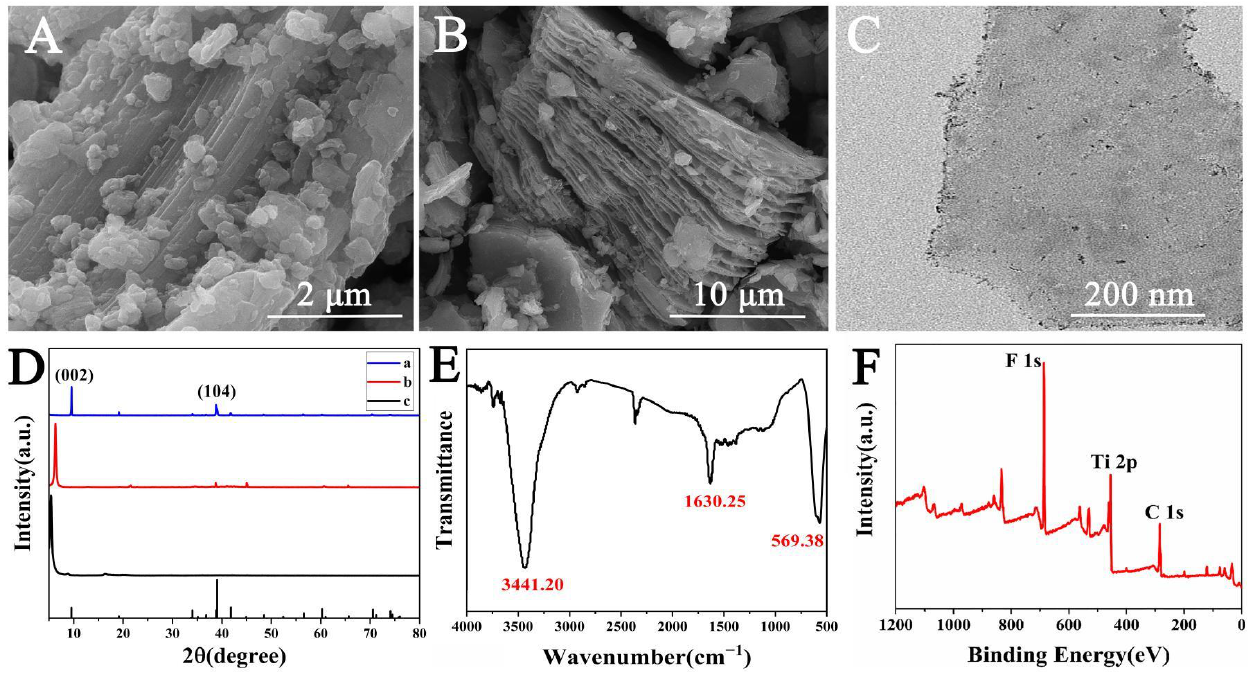
Figure 2. SEM images of ( A ) Ti 3 AlC 2 and ( B ) Ti 3 C 2 . ( C ) TEM image of the MXene flake. ( D ) XRD patterns of MAX (a), delaminated MXene (b), and single-layer MXene (c). ( E ) FT-IR spectrum and ( F ) XPS pattern of the MXene nanosheets.